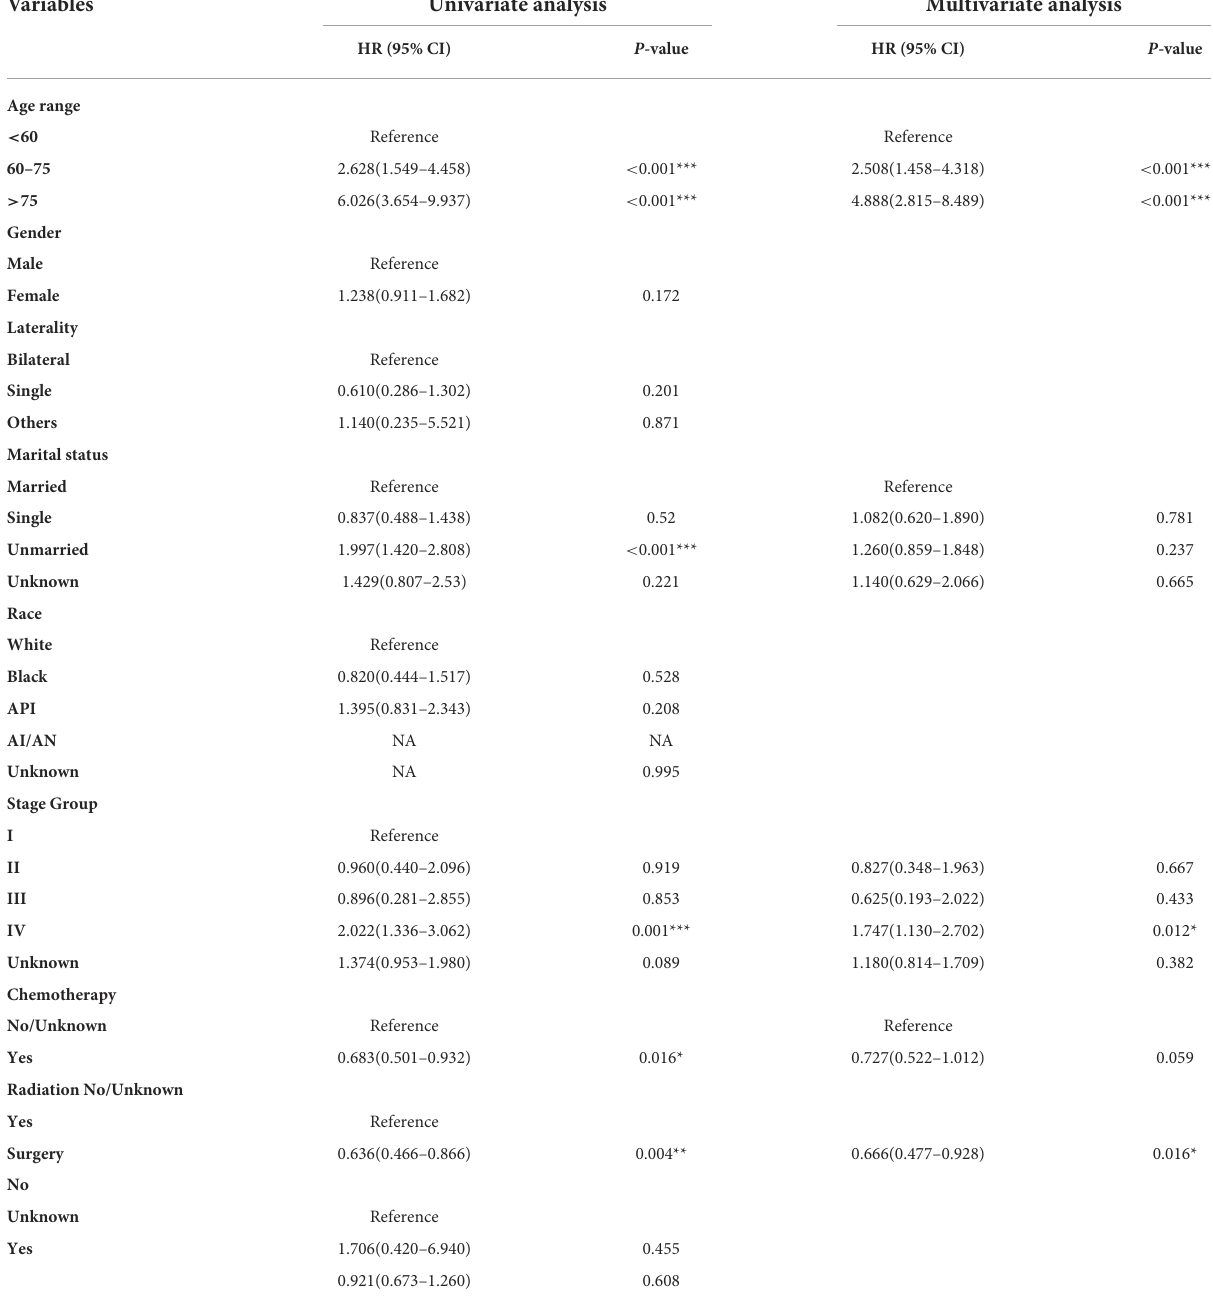
TABLE 3 Univariate and multivariate analysis of factors with the risk of OS for orbital DLBCL patients identified in the SEER Program database from 2000 to 2017. Variables Univariate